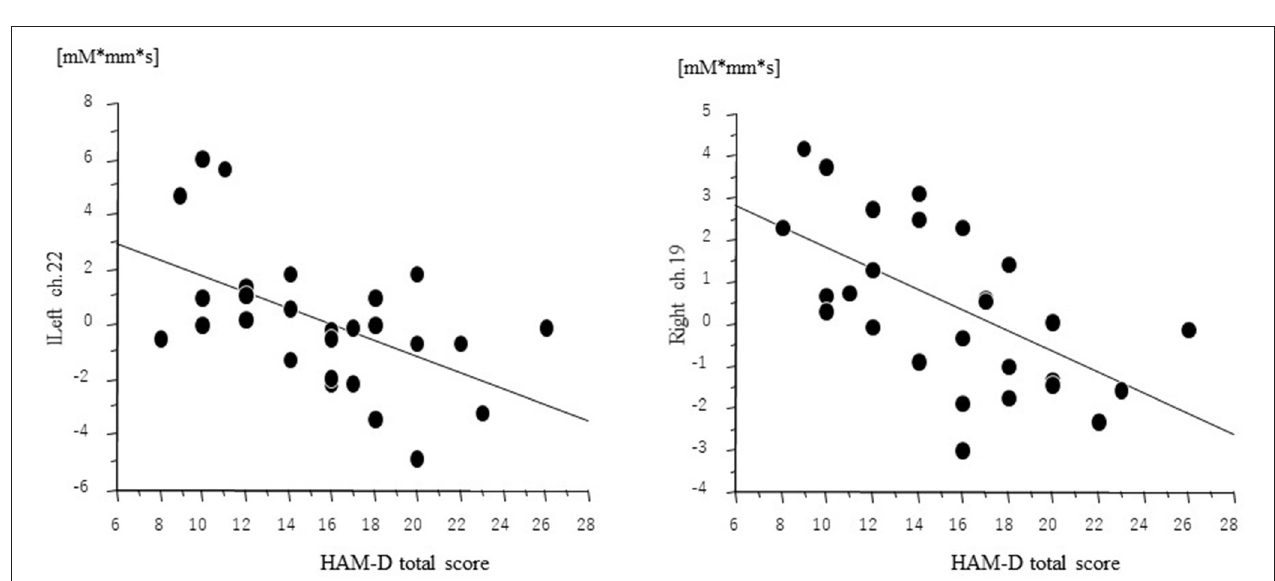
FIGURE 4 | Relation among oxygenated hemoglobin changes ( 1 oxy-Hb) and HAM-D total